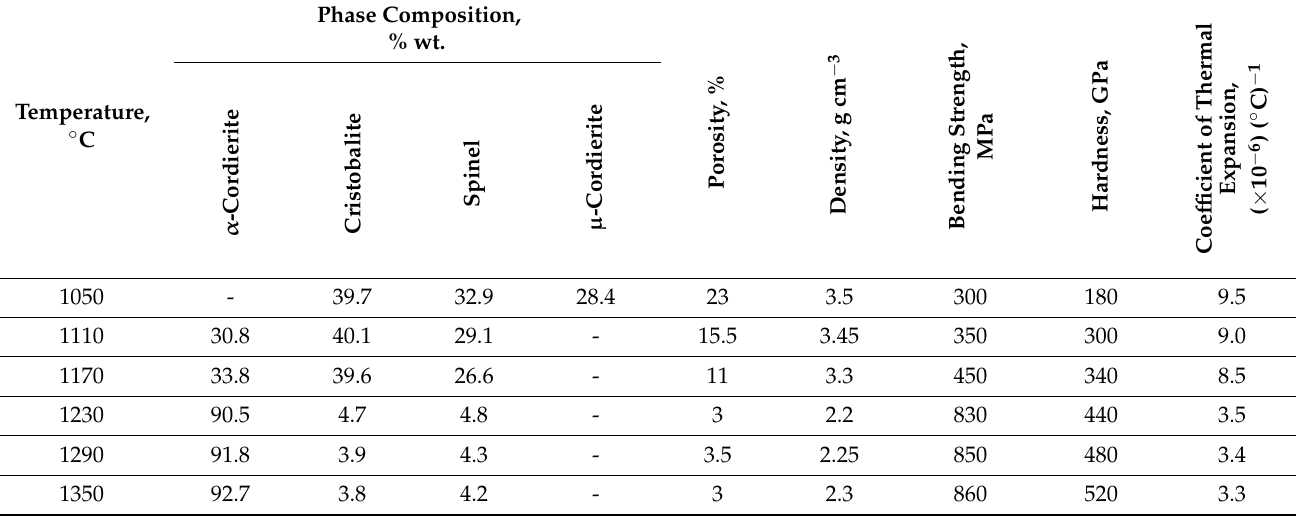
Table 11. Composition and properties of refractory cordierite from rice husk silica. Data from [50]. Phase